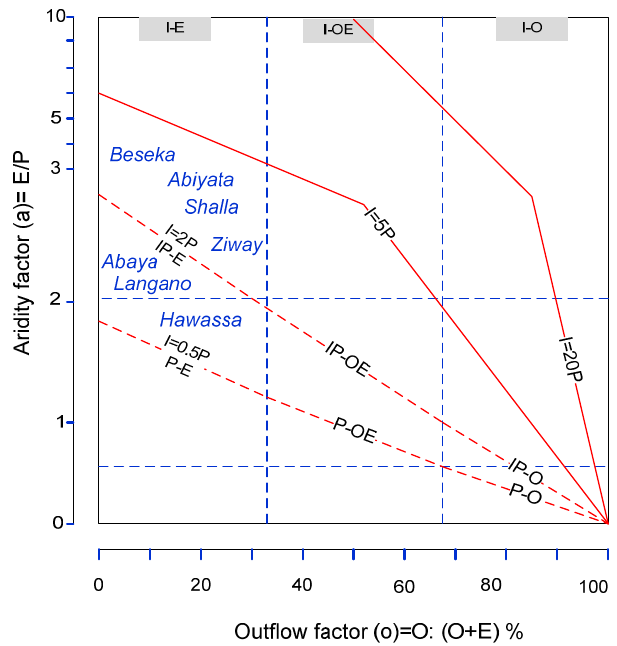
Figure 3. Classification of lakes by water balance criteria (aridity-outflow). (N.B: Lake Chamo was not considered in this result due to limited data